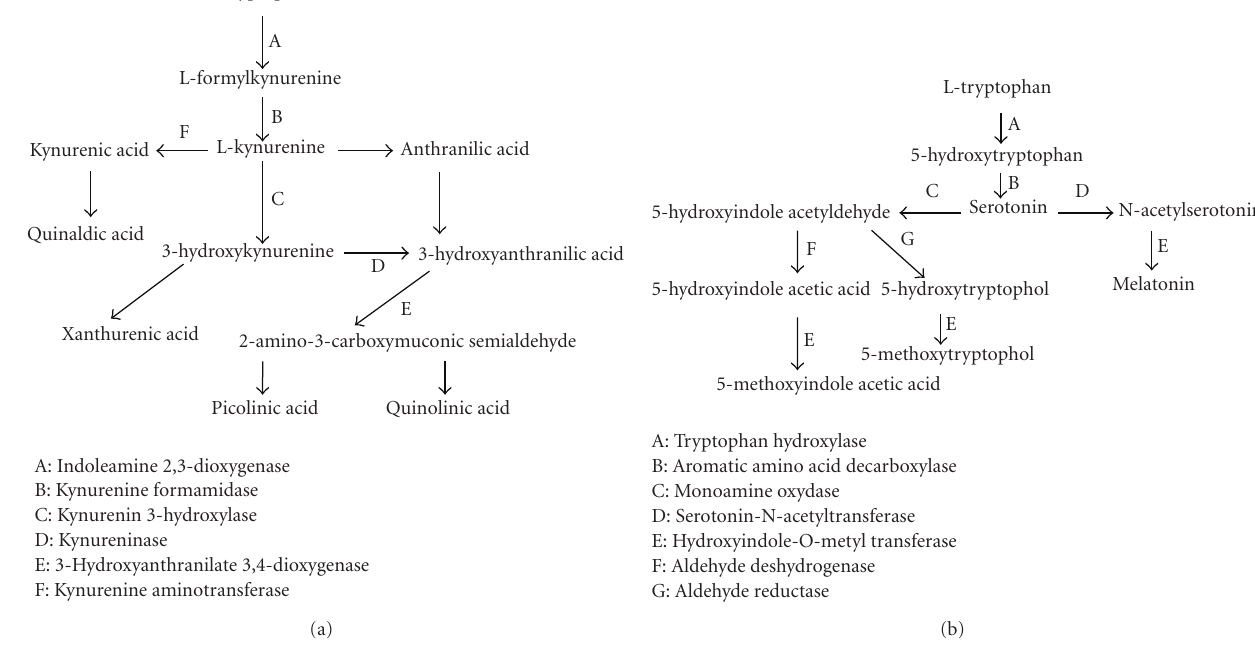
Figure 1: (a) The IDO-1 pathway. (b) the THO